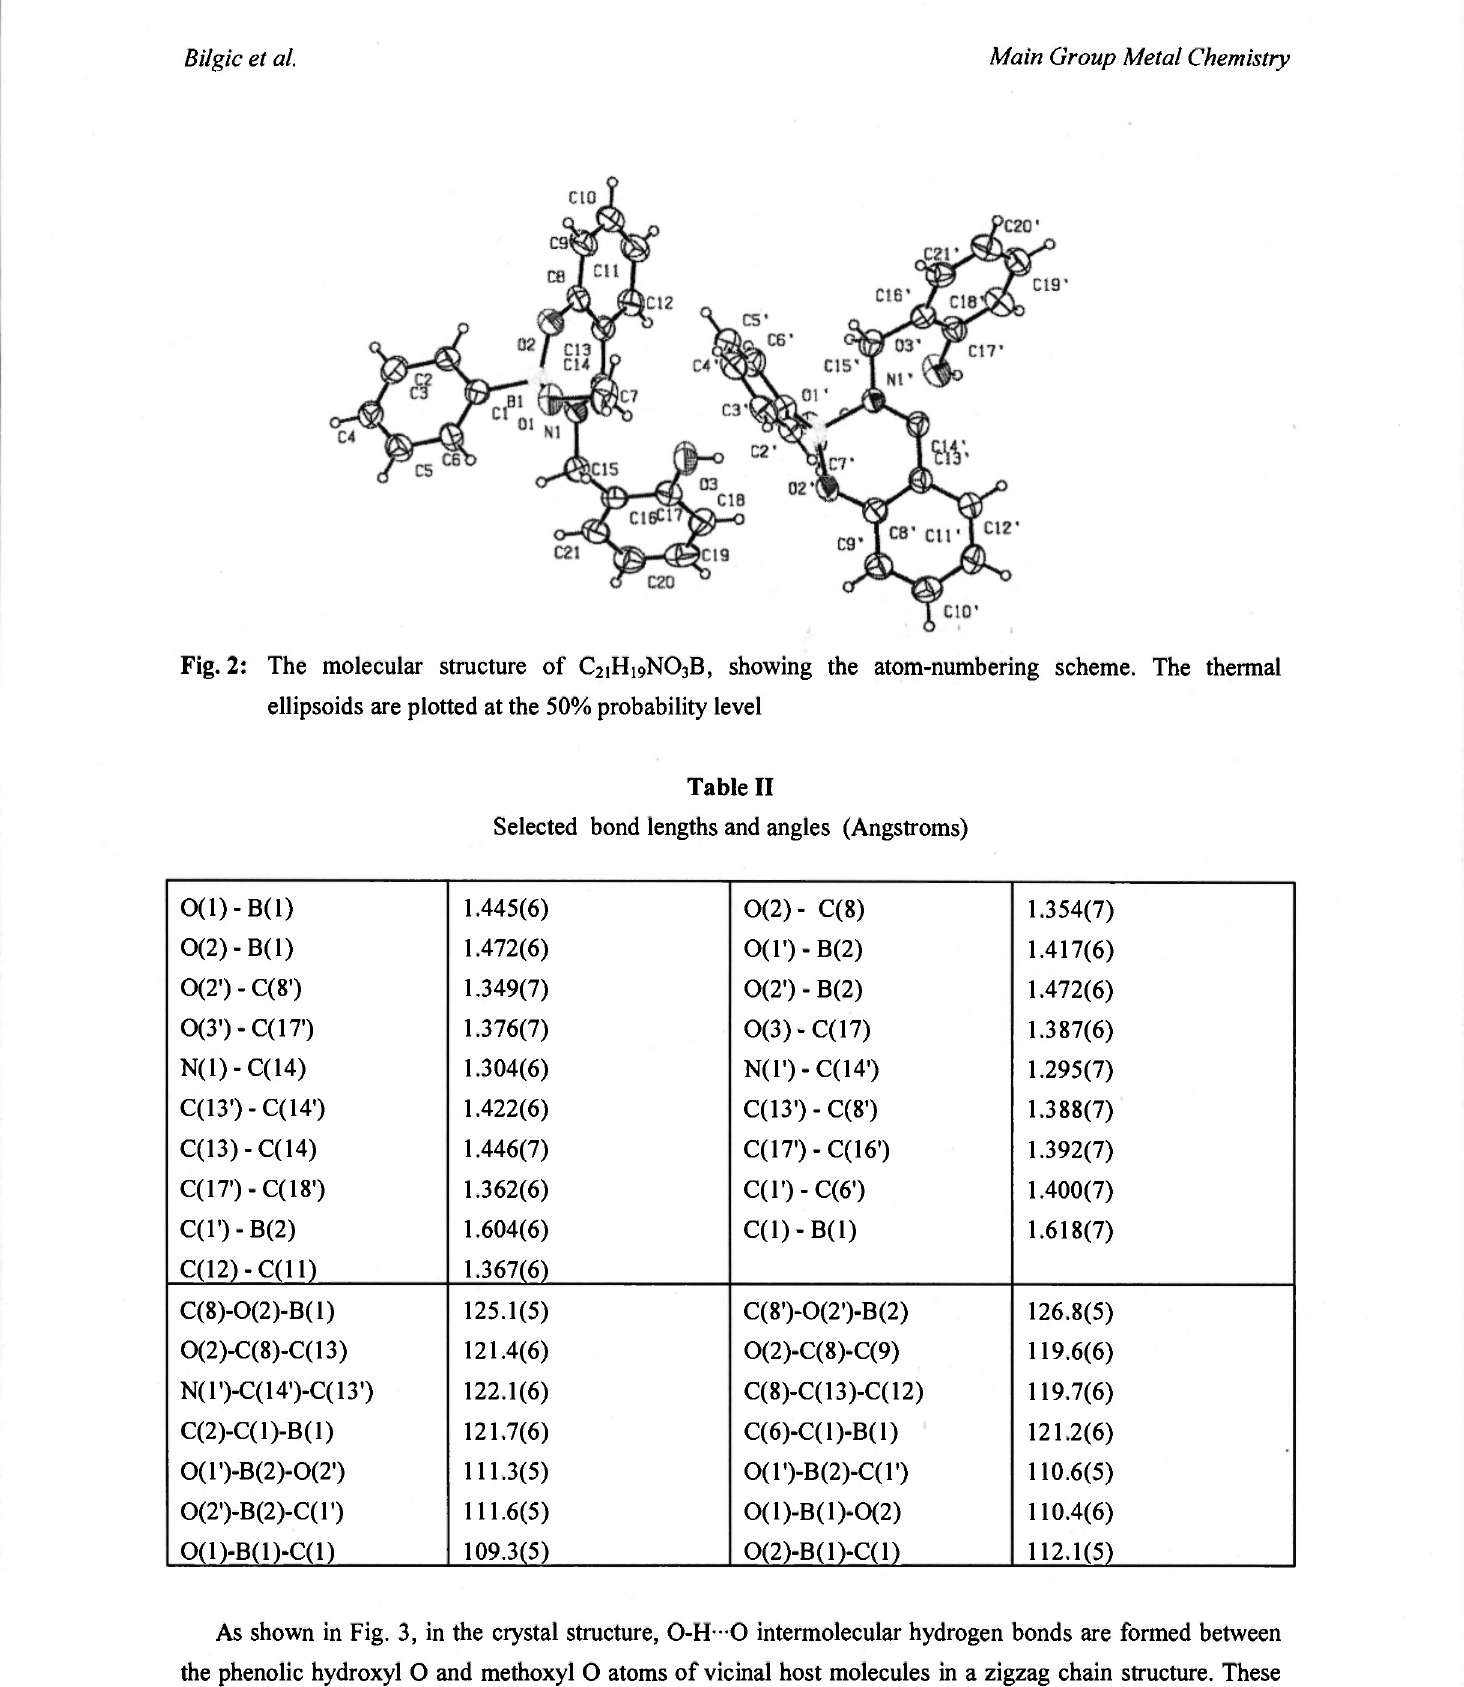
Fig. 2: The molecular structure of C 2 IHI 9 N0 3 B, showing the atom-numbering scheme. The thermal ellipsoids are plotted at the 50% probability level